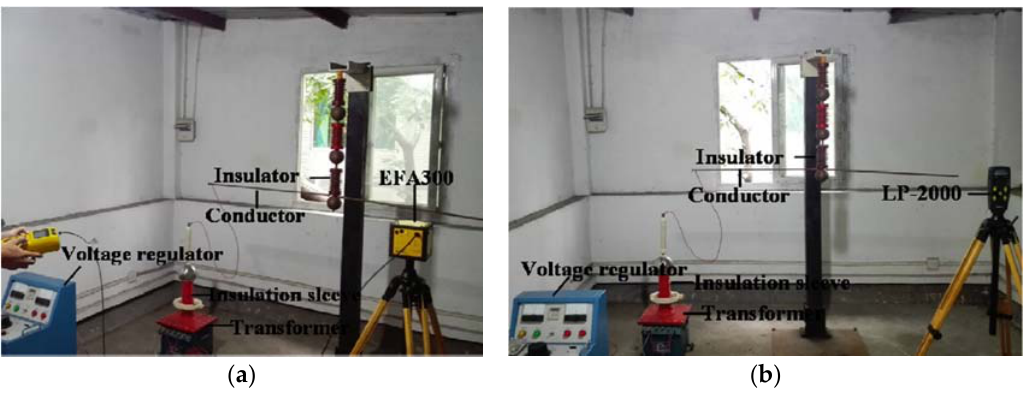
Figure 9. Experimental measurement (in the absence of a human body). ( a ) Measuring worksite of Narda EFA-300; ( b ) measuring worksite of Type LP-2000. Table 4. Technical characteristics of the experimental equipment.